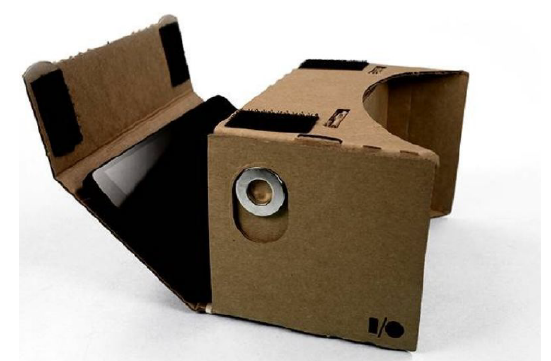
Figure 2. Google Cardboard device used in three-dimensional image visualization